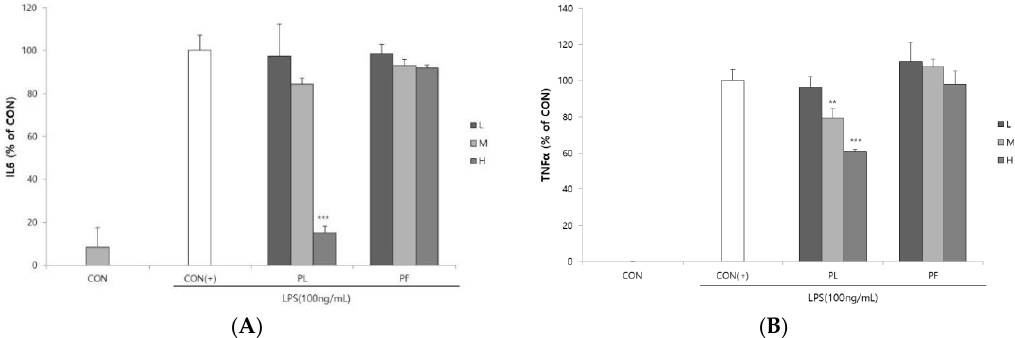
Figure 2. Suppression of ( A ) interleukin (IL)-6 and ( B ) tumor necrosis factor (TNF)-α secretion by the extracts of pepper leaves (PL) and pepper fruits (PF) in lipopolysaccharide (LPS)-stimulated RAW 264.7 cells. RAW 264.7 cells were treated with 100 (L), 200 (M), and 500 (H) µg/mL PL and PF extracts in the presence of 100 ng/mL LPS for 18 h. Statistical significance is based on the difference compared with CON(+) (* p < 0.05, ** p < 0.01, *** p < 0.001).